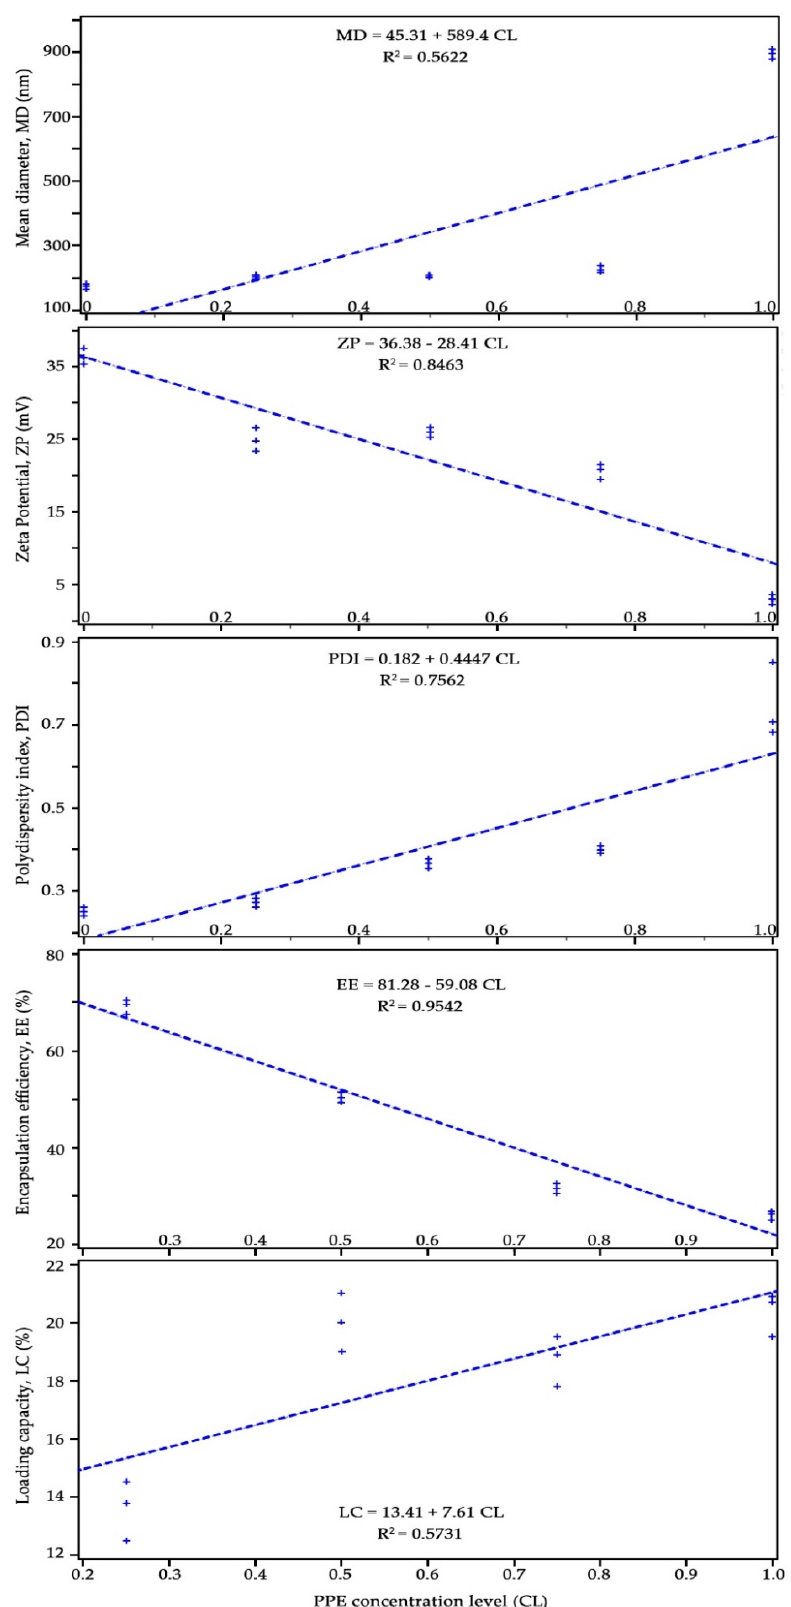
Figure 2. Pearson’s correlation between PPE concentration levels (as an independent variable) and dependent variables: MD: mean diameter; ZP: zeta potential; PDI: poly-dispersity index; EE: encapsulation efficiency; LC: loading capacity.